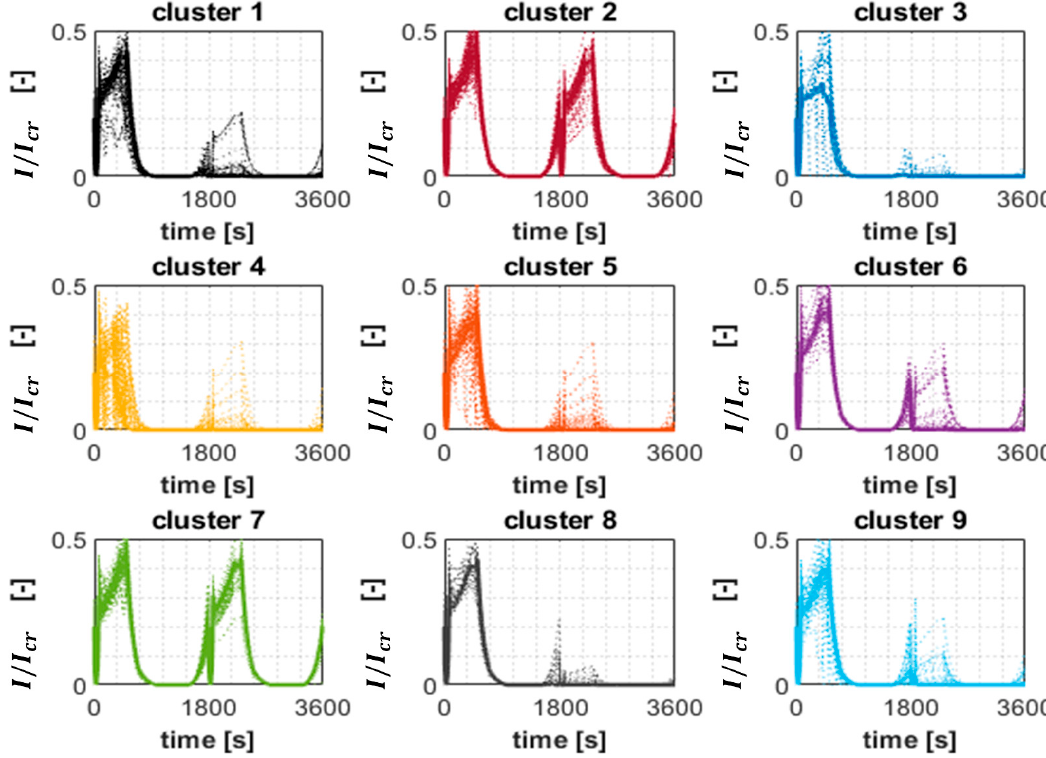
Energies 2021 , 14 , 5552 Figure A3. Nine clusters of (cid:1846) (cid:3035)(cid:3046) transient scenarios generated by POD-based Kriging metamodels. Figure A3. Nine clusters of T hs transient scenarios generated by POD-based Kriging metamodels.